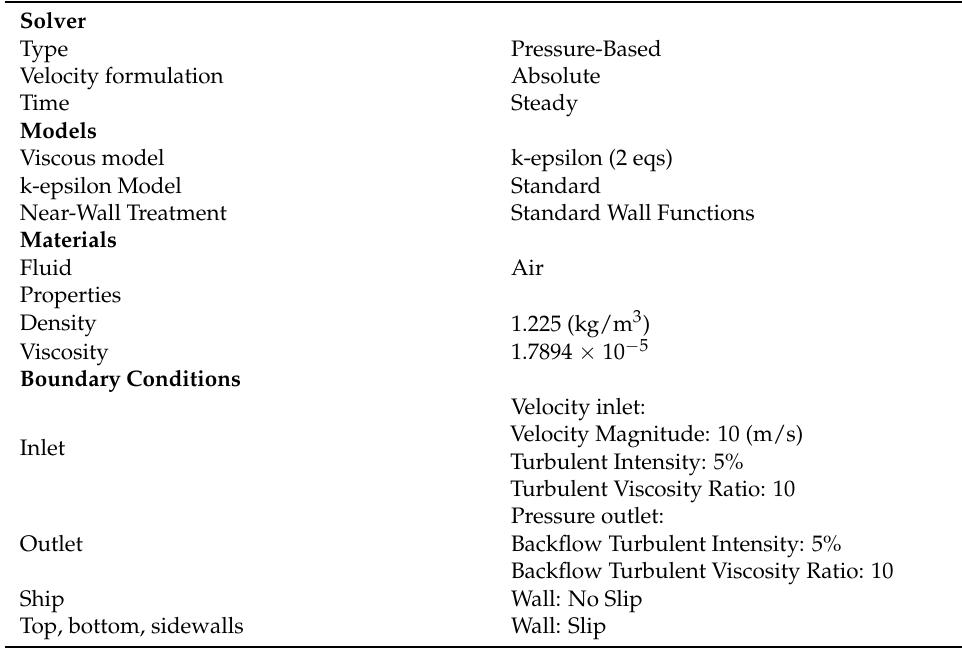
Table 2. Solution